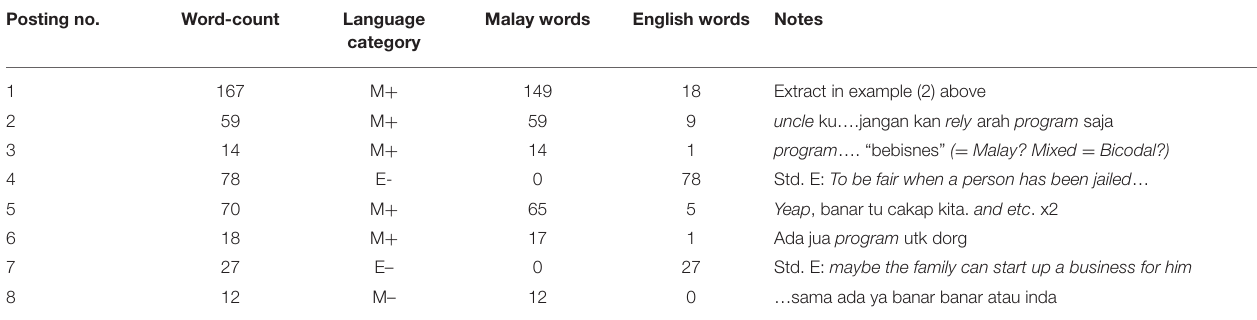
TABLE 2 | Language choice across one Brunei subreddit thread; topic: employment of ex-prisoners. Posting